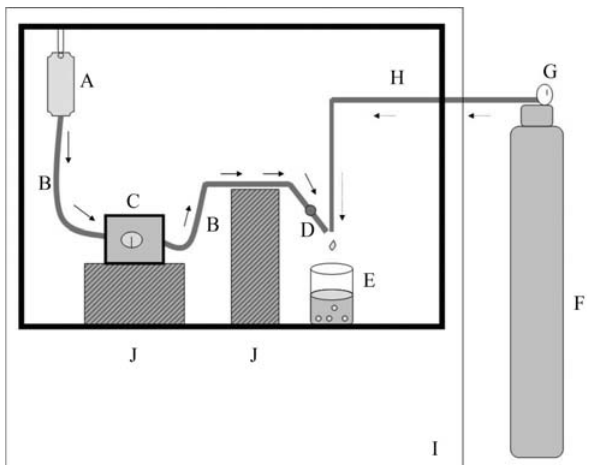
Figure 1 - Diagram of the microcapsule generator. a) Viaflex bag contain- ing low viscosity Dulbecco’s Modified Eagle’s Medium (D-MEM) sup- plemented with 1.5% (w/v) sodium alginate containing baby hamster kid- ney (BHK) cells at a concentration of 2 X 10 5 cell mL -1 ; b) model EQL P parenteralpump;c)modelLF2001volumetricinfusionpump;d)25gauge needle; e) beaker containing 125 mM CaCl 2 solution; f) compressed air cylinder; g) flow meter; h) 80 cm PVC tubing; i) laminar flow hood; and j) support.